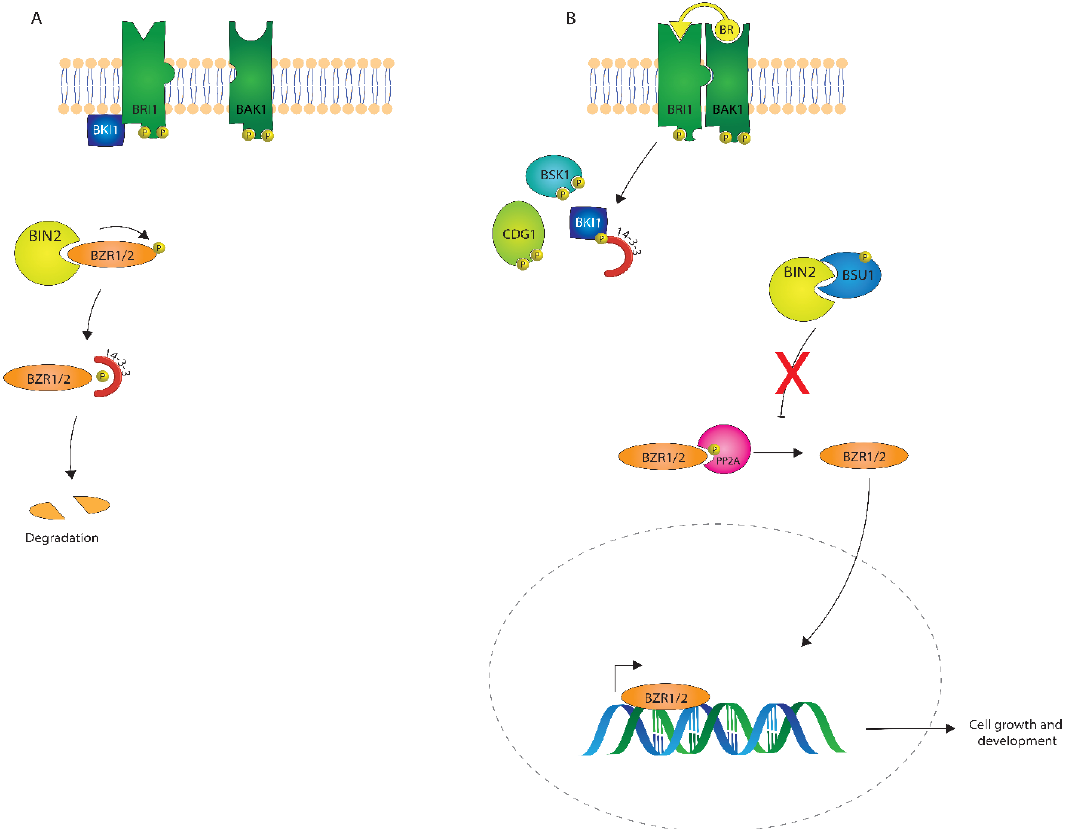
Figure 4. A depiction of brassinosteroid (BR) signaling both in the absence ( A ) and presence ( B ) of a BR